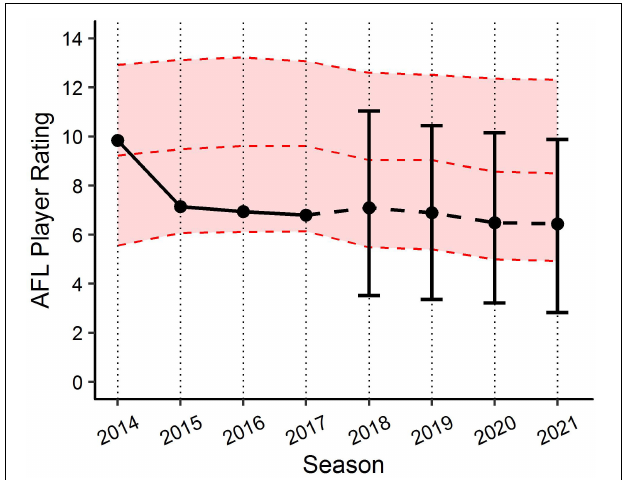
FIGURE 6 | Benchmark levels of AFL Player Ratings for a specific player using the age linear mixed model. Black lines represents actual performance to 2017 and player specific expectation ( ± 90% PI) of performance from 2018. Red ribbon represents fixed effects estimates based on characteristics of same